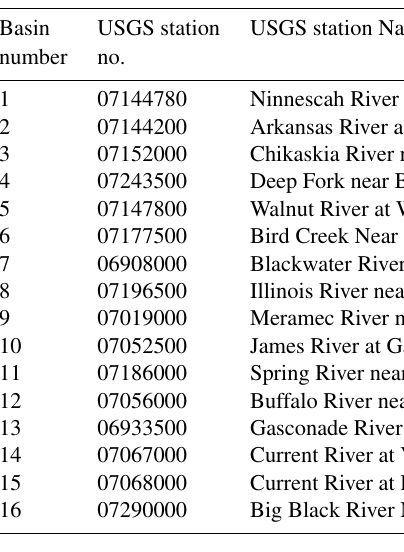
Table 1. Note that GRACE Level-3 values capture